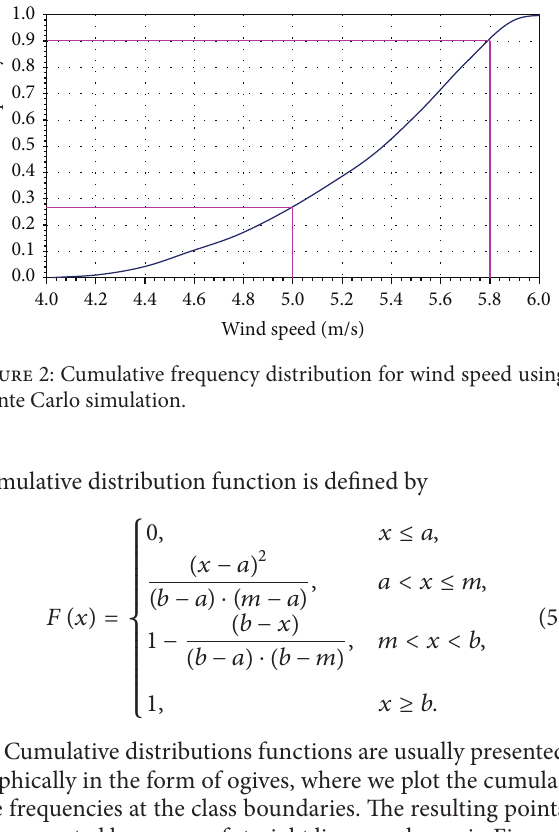
Figure 4: Monte Carlo simulation of cumulative frequency distri- bution for daily energy output.